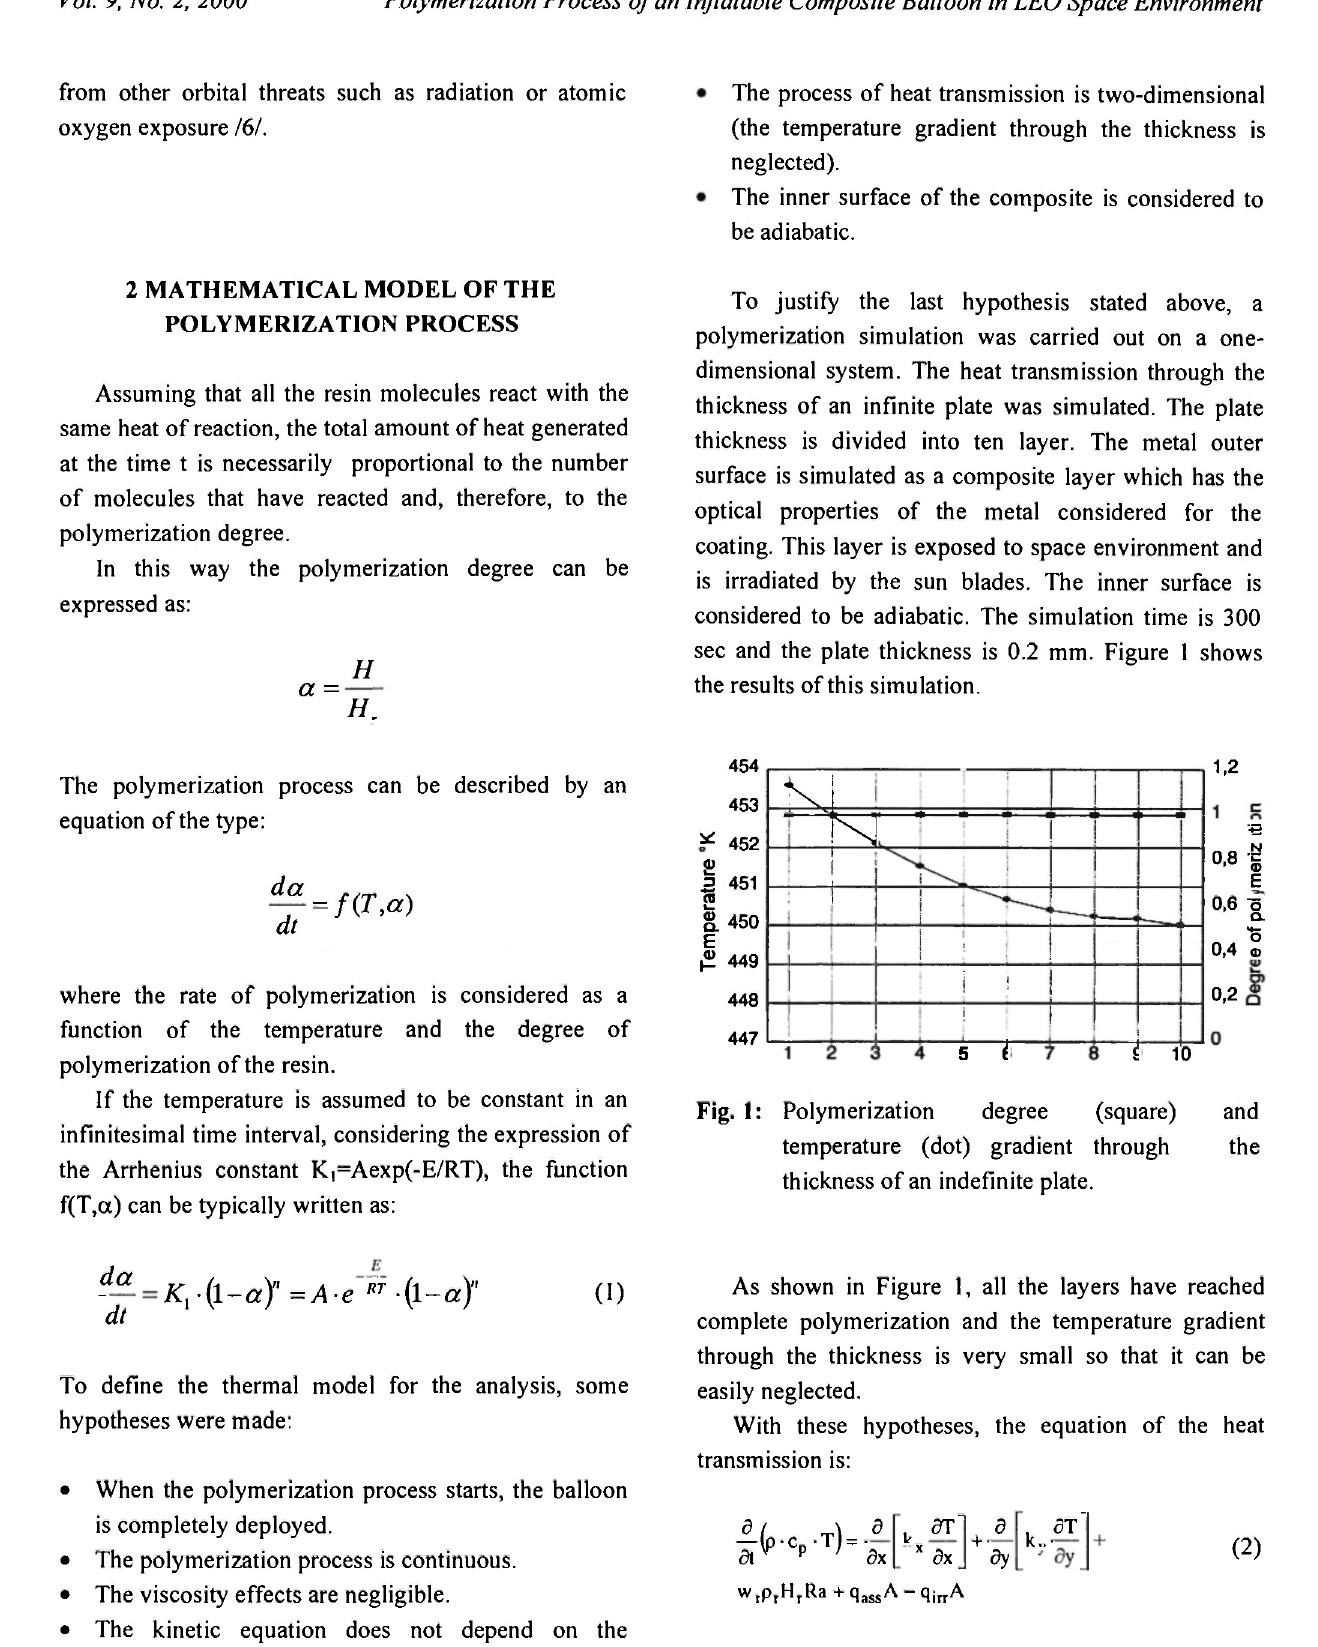
Fig. 1: Polymerization degree (square) temperature (dot) gradient through thickness of an indefinite plate.